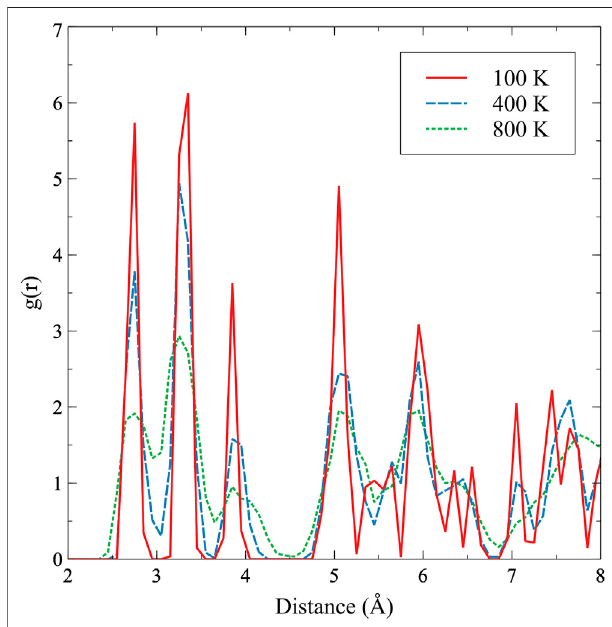
FIGURE 8 | The radial distribution function in α -U at 100, 400, and 800